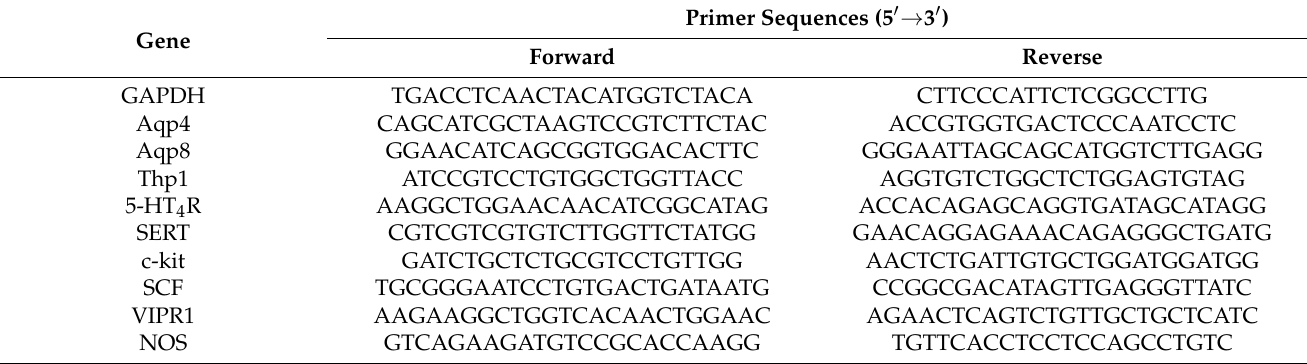
Table 1. The specific RT-qPCR primers for target